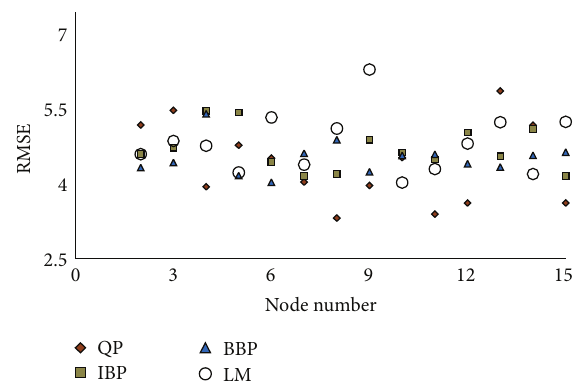
Figure 1: The selected RMSE versus node number of the photodeg- radation network’s hidden layer for QP, IBP, BBP, and LM algorithm. The smallest RMSE belong to node of 8 (QP), 15 (IBP), 6(BBP) and 10